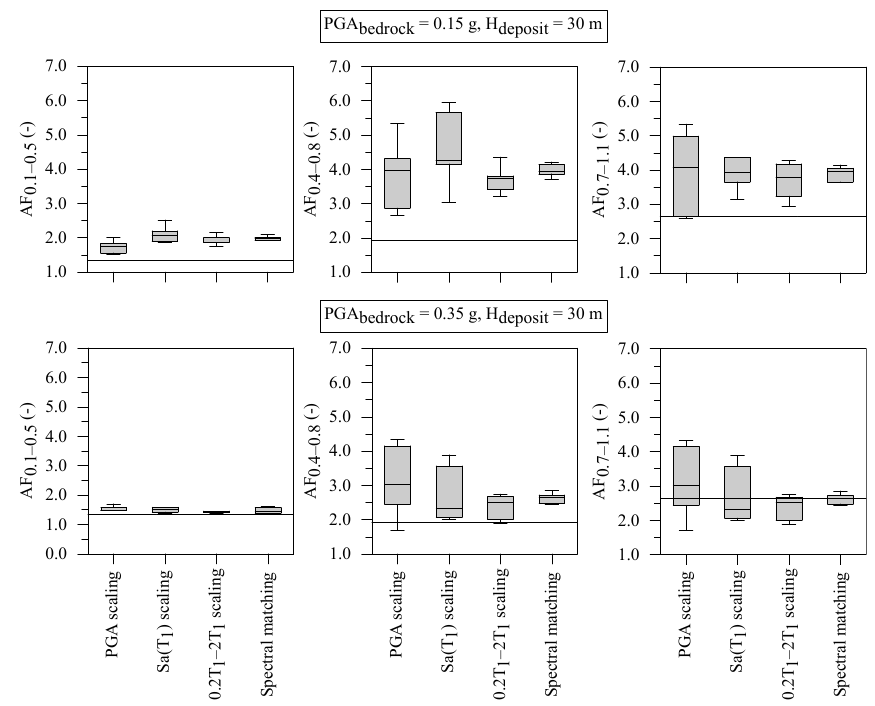
Figure 13. Box plots of AFs for a deposit thickness equal to 30 m and VS 2 (z), considering 4 selection strategies for the input motions. The constant value retrieved from EC8 (thin black line) refers to ground type D.